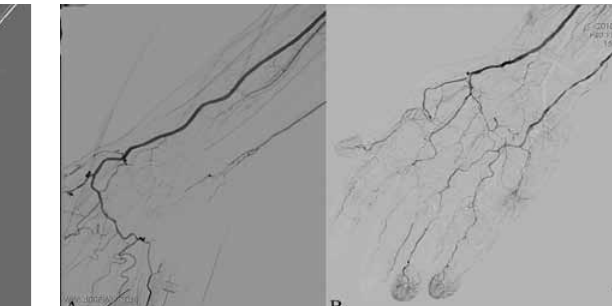
Figure 2. Selective angiography shows an ulnar artery occlusion (Figure 2A) with patent palmar arch, and a critical ulnar artery stenosis with week and atherosclerotic palmar arch in Buerger disease (Figure